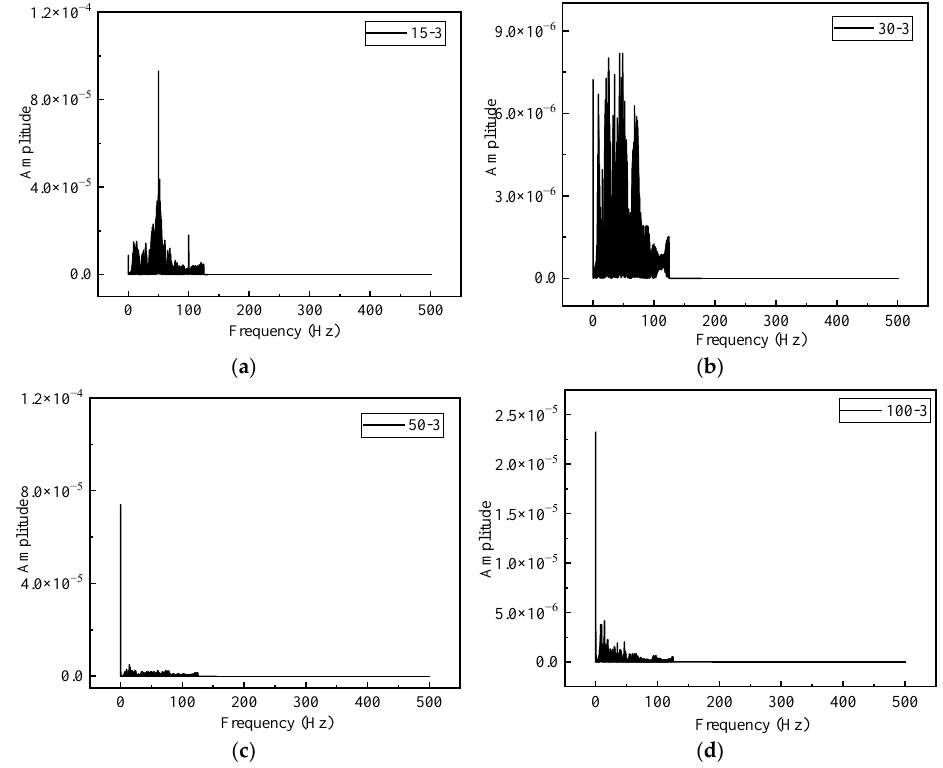
Figure 9. Fourier spectrum curves of acceleration in the south–north direction: ( a ) 15-3; ( b ) 30-3; ( c ) 50-3; ( d ) 100-3.